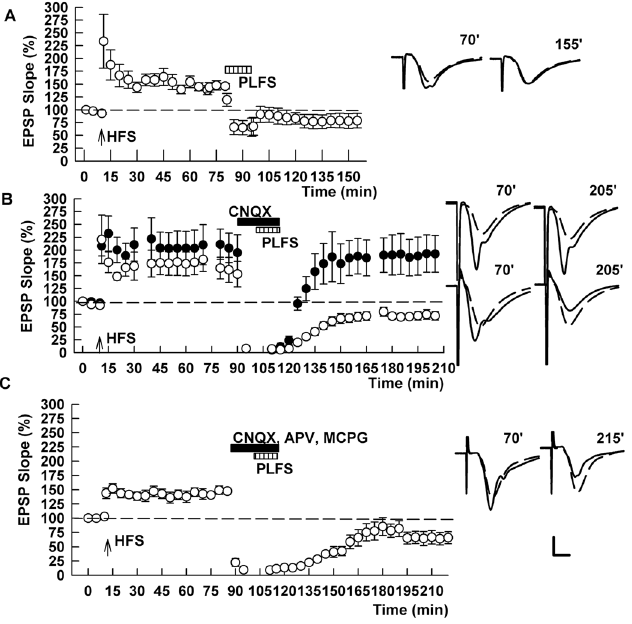
Fig 1. Glutamate receptor antagonists do not block TA-induced SC depotentiation. (A) The graph shows the time course of change in SC EPSPs following a single 100 Hz x 1 sec HFS delivered to the SC pathway (arrow). After establishing SC LTP, 1 Hz LFS of the TA (perforant path) inputs to CA1 (PLFS, hatched bar) reversed LTP. (B) Following stable SC LTP induction 30 μ M CNQX (black bar) was administered and inhibited SC EPSPs completely. CNQX did not prevent LTP-D by PLFS (white circles) and had no effect on LTP by itself (black circles). (C) A combination of glutamate receptor antagonists (30 μ M CNQX, 100 μ M APV and 500 μ M MCPG) also failed to prevent PLFS-induced LTP-D. Traces to the right of the graphs show representative field EPSPs at the times indicated (black lines) with baseline EPSPs shown as dashed traces. Calibration: 1 mV, 5